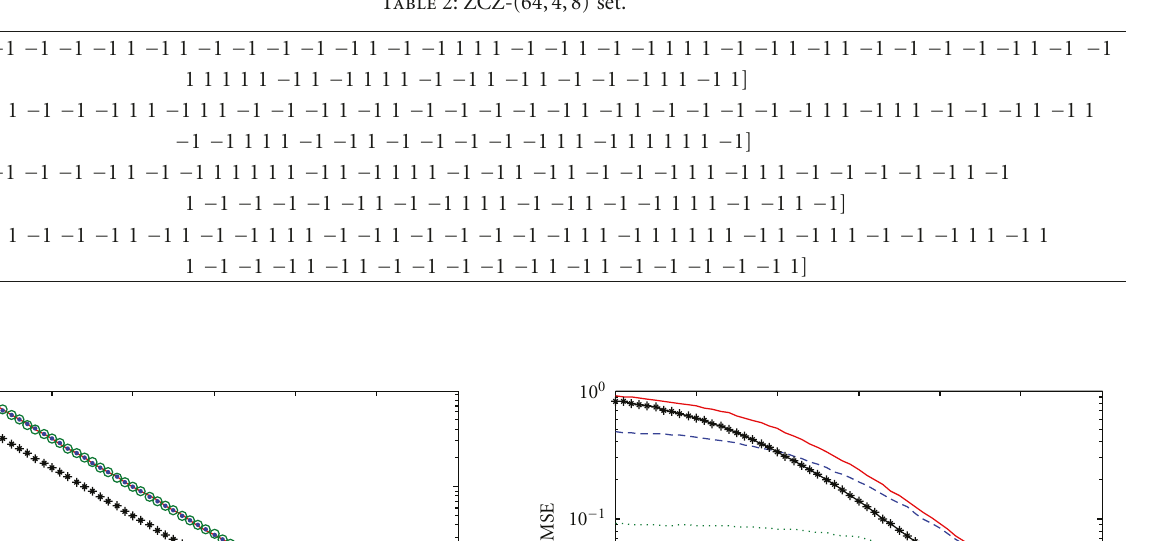
Table 2: ZCZ-(64,4,8) set.